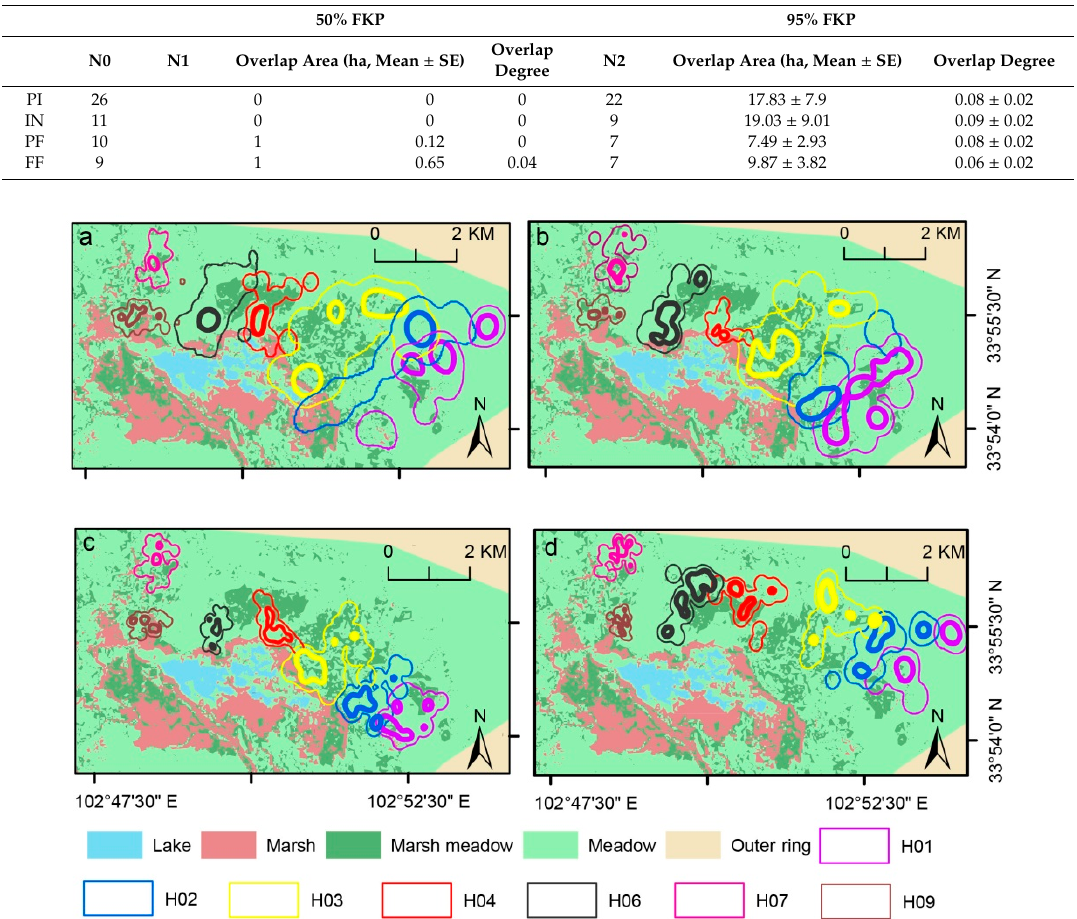
Figure 4. Seven of 13 black-necked crane pairs’ home-range areas (e.g., H01) during four stages (( a ), preincubation; ( b ), incubation; ( c ), postfledging; and ( d ), fully fledged) at ( a ) Flower marsh in study area. Differently colored lines, home ranges of different breeding pairs; thick lines of same color, 50% FKP; corresponding thin lines, 95% FKP.